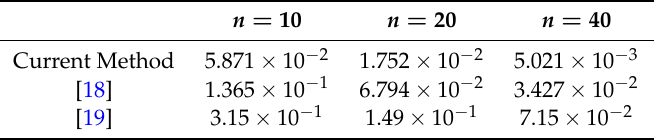
Table 14. Comparison of the maximum absolute errors of the fifth order derivatives of y 1